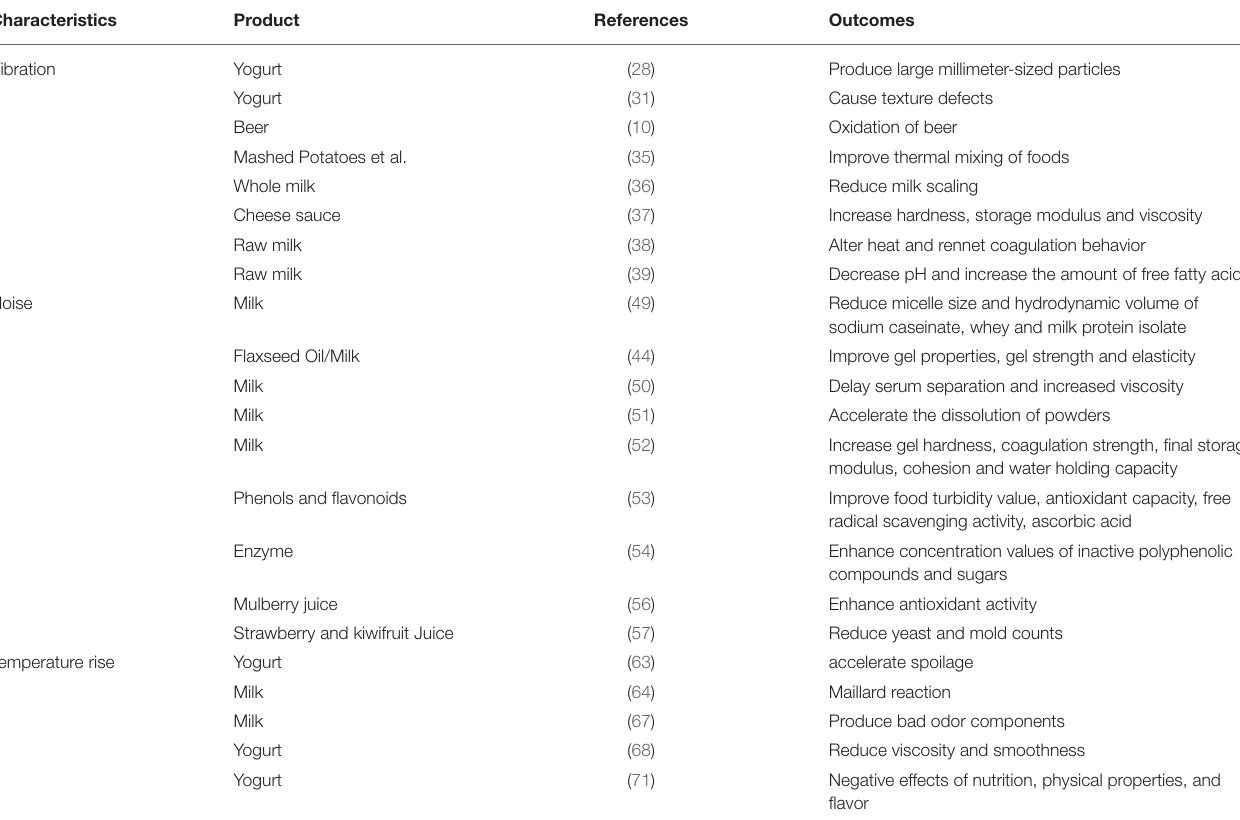
TABLE 1 | A summary table of all mentioned papers outcomes.